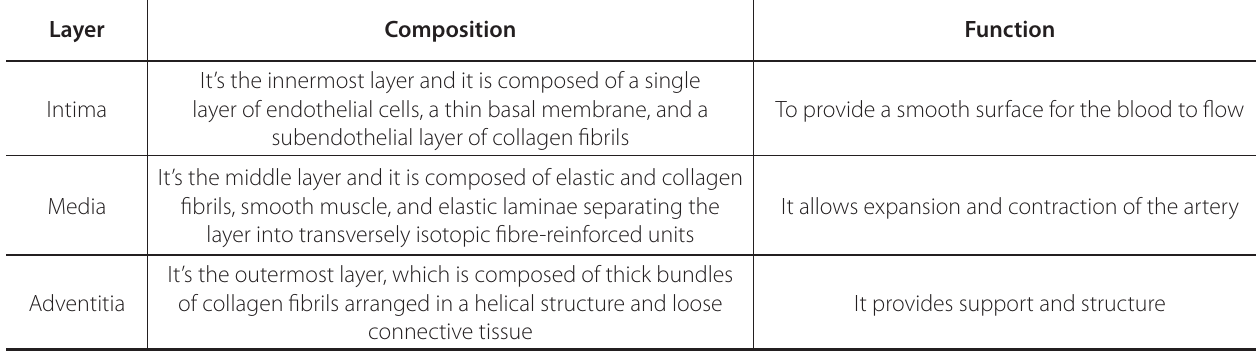
Table 1 . Composition and function of the layers of a blood vessel. Layer Composition